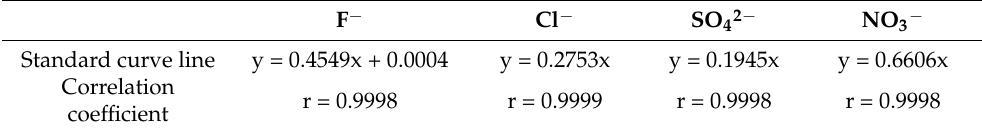
Table 2. Standard curve of four